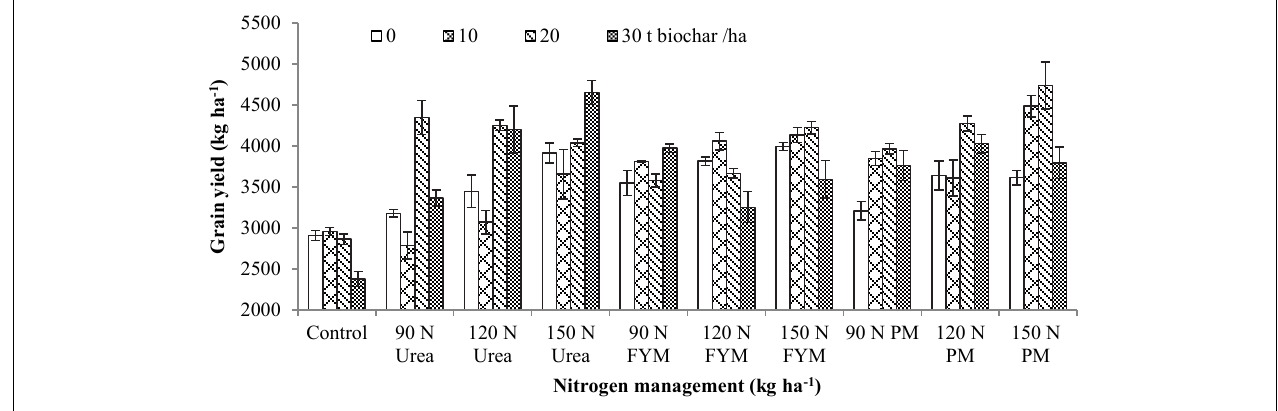
FIGURE 1 | Interactive effect of biochar and N levels applied from different sources on grain yield of wheat. Bars on the graph denote SE of mean ( n = 3). FYM, farmyard manure; PM, poultry manure.